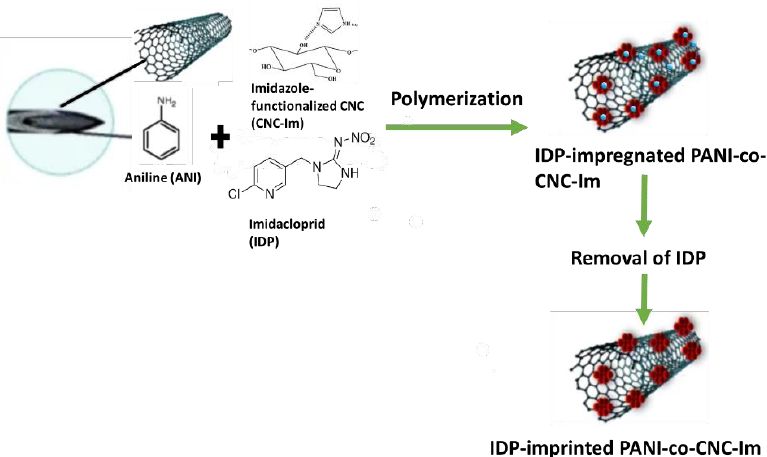
Figure 1. Schematic for the fabrication of the IDP-imprinted PANI/CNC@CNT/CNC MN sensor.